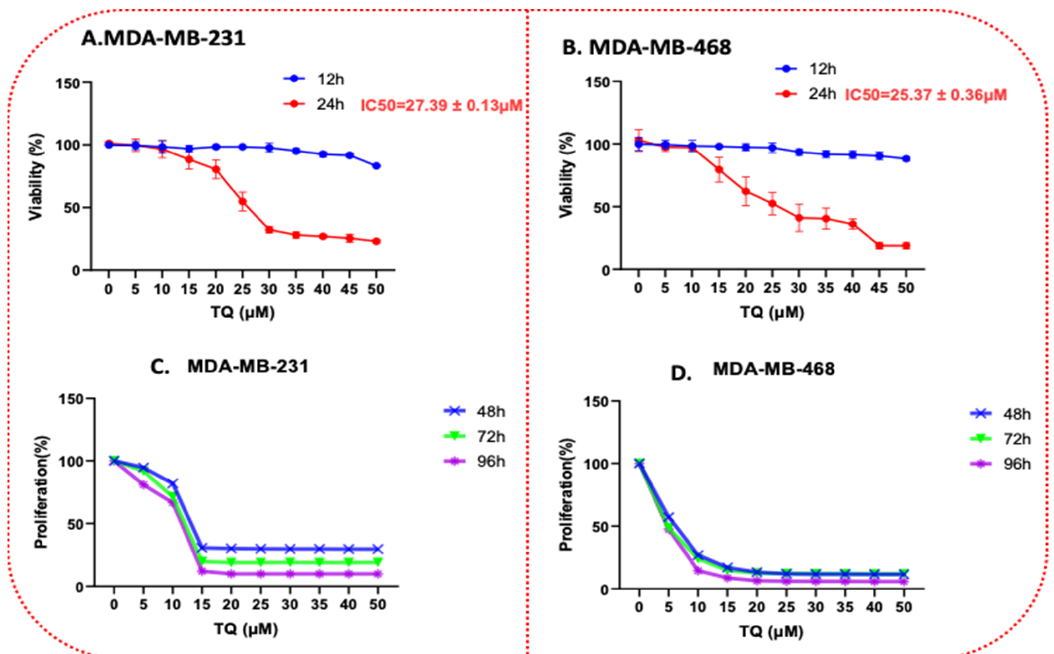
Figure 2. TQ reduces cell viability in TNBC cells using Alamar Blue. Both cell lines, MDA-MB231 and MDA-MB-468, were plated and treated similarly for 12 and 24 h in a time-dependent manner with TQ at concentration ranges of 0–50 µM ( A , B ). The graph shows the cell viability data expressed as percentages of cell survival compared to the control. Anti-proliferative effect of TQ in MDA-MB-231 I and MDA-MB-468 ( C , D ) TNBC cell lines. Both cell lines were seeded in 96-well plates at 1 × 10 4 cells/100 µ L/well and incubated for 48, 72, and 96 h with TQ at concentration ranges of 0 to 50 µ M. Each data point presents the average ± SEM of three independent experiments, n = 6 each. One-way ANOVA was used to determine the significance of the difference between the control and treated